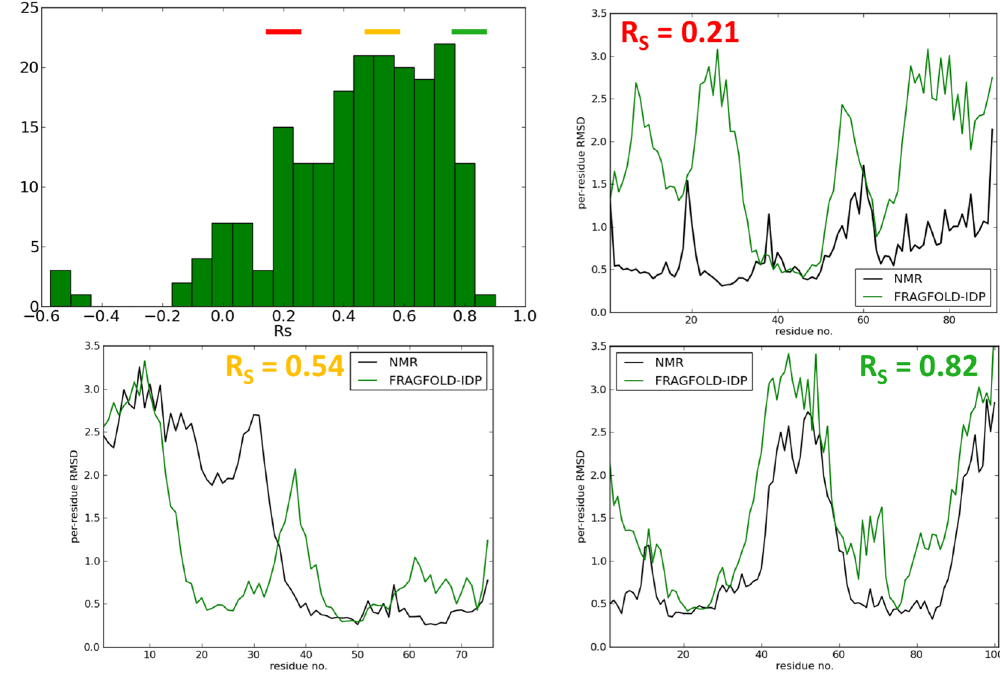
Figure 1. Distribution and examples of FRAGFOLD-IDP results on the 200 protein dataset. Top left panel shows the distribution of FRAGFOLD-IDP results. Sample disorder profiles of poor (top right), medium quality (bottom left) and excellent (bottom right) FRAGFOLD-IDP predictions are compared to respective NMR PDB ensembles.